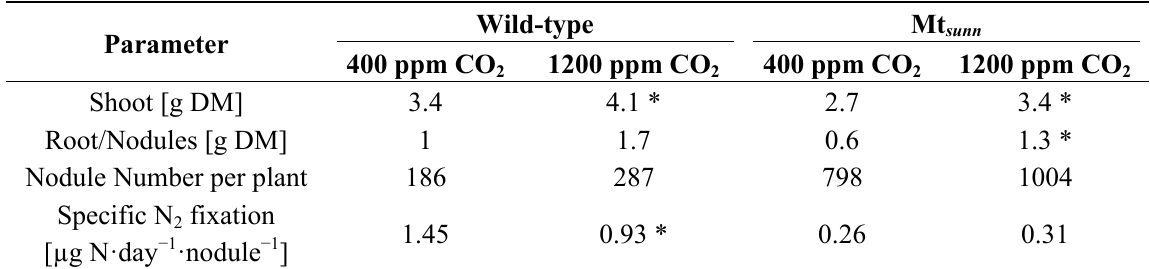
Table 3. Growth and nitrogen fixation of wild-type and sunn M . truncatula plants. Data